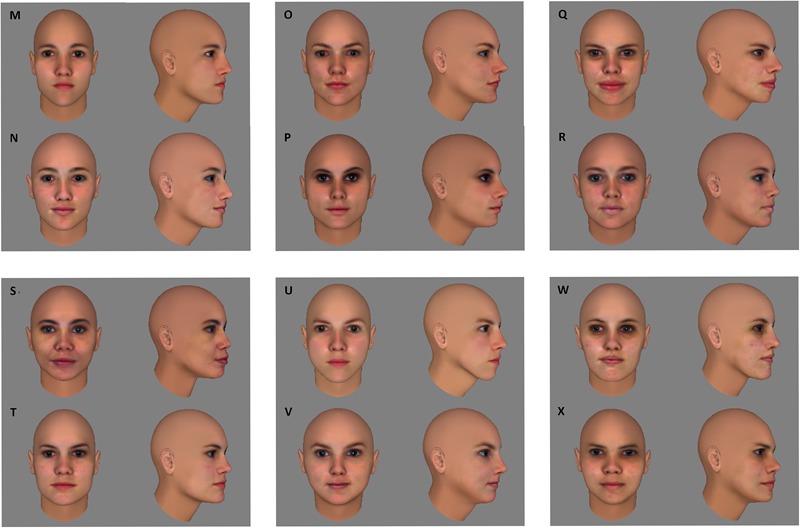
For the control conditions of the fMRI experiment, six extra face pairs (MN, OP, QR, ST, UV, WX) were selected that were equal in pixel-wise similarity to the six face pairs of the experimental conditions (see Figure 1).